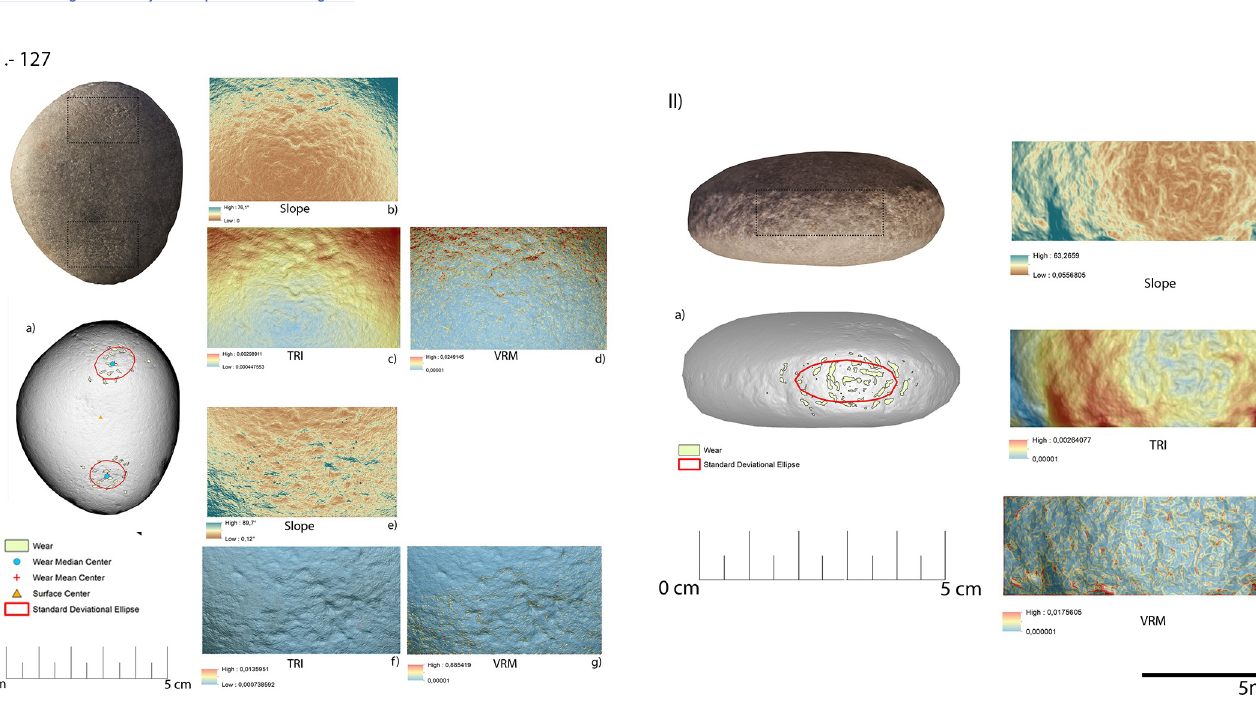
PLOS ONE | https://doi.org/10.1371/journal.pone.0207773 December12,